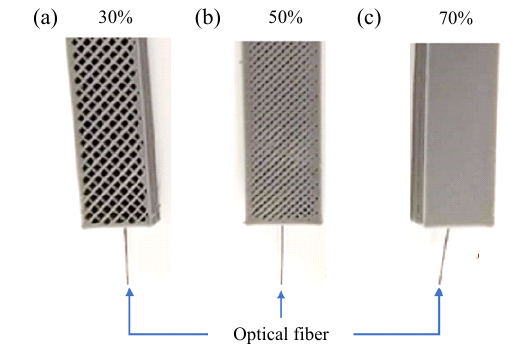
Fig. 3 Pictures of the taper cages with (a) 30 %, (b) 50 %, and (c) 70 % material filling